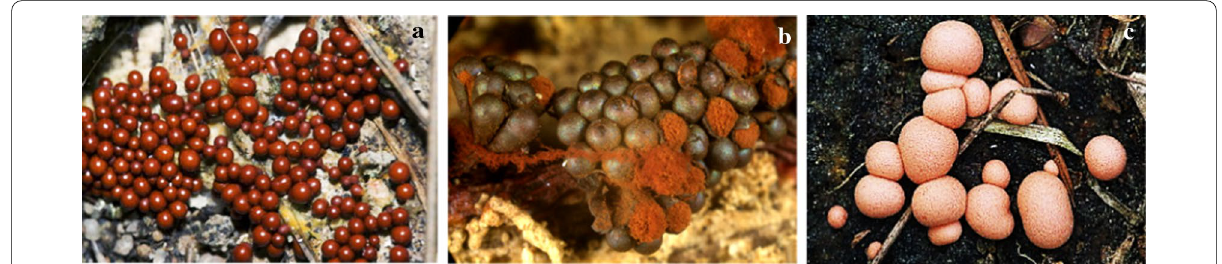
Fig. 5 a Leocarpus fragilis, b Metatrichia vesparium, c Lycogala epidendrum (https:// www. disco verli fe. org, https:// www. natur epl.